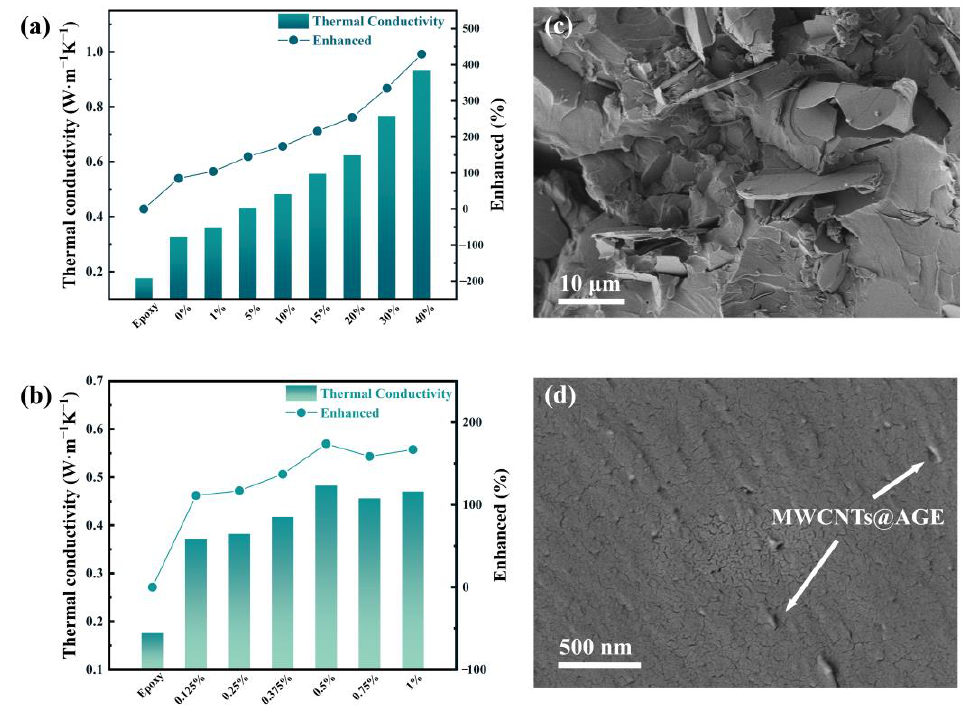
Figure 3. ( a ) Thermal conductivity and enhanced efficiency of composites with BNNSs (with 0.5 wt.% MWCNTs@AGE). ( b ) Thermal conductivity and enhanced efficiency of composites with MWCNTs@AGE (with 10 wt.% BNNSs). ( c , d ) SEM images of BNNSs/MWCNTs/SiO 2 /epoxy composites.